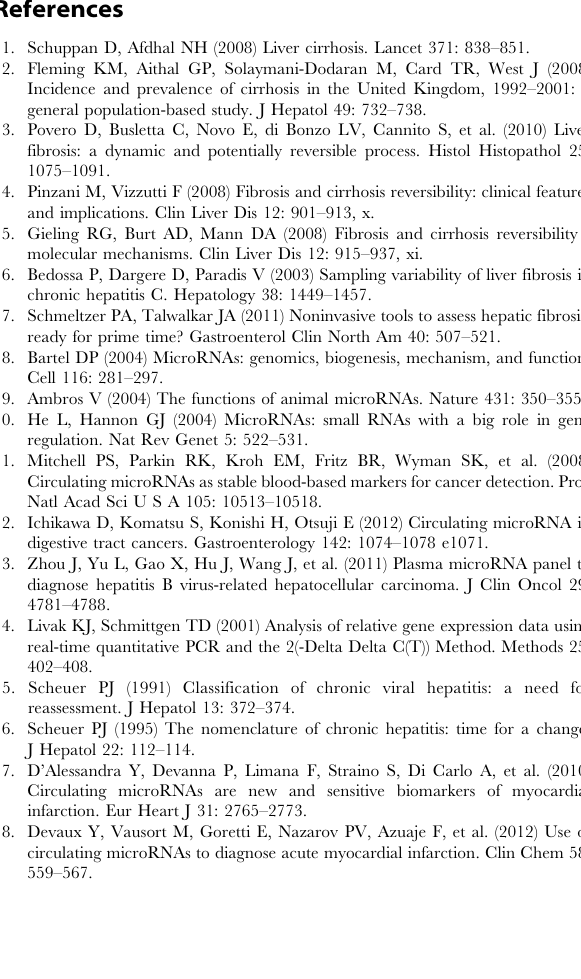
qPCR, quantitative real-time PCR. Table S1, General inclusion criteria. Table S2, The primer sequences. Table S3, Candidate miRNAs from microarray result. Table S4, Evaluation of the expression of 6 selected miRNAs by qPCR. Table S5, Differentially expressed miRNA in the training phase. Table S6, The diagnose power of single clinical indicators. Table S7, Liner regression between miRNAs level and clinical